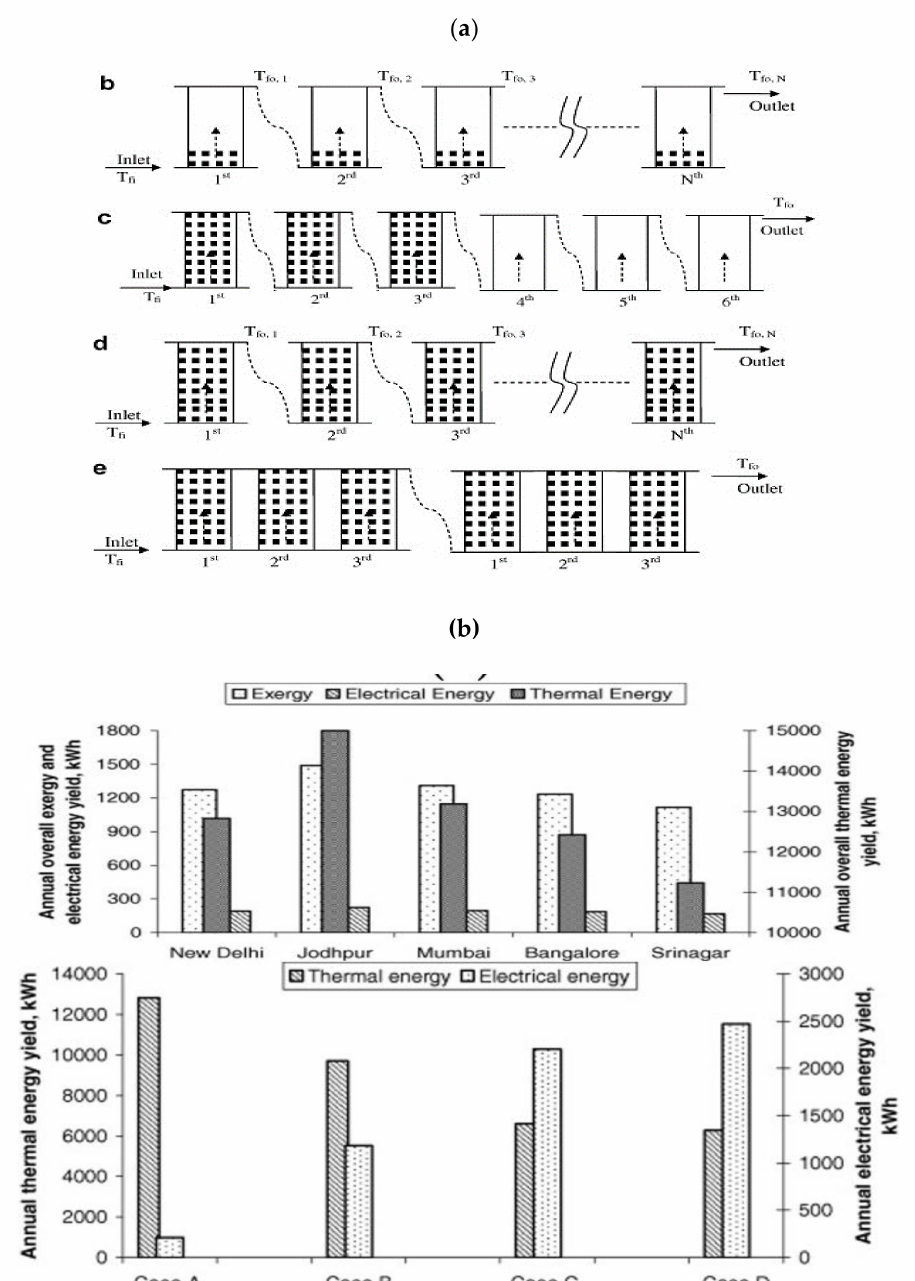
Figure 10. ( a ) Four different configurations (collectors partially covered by PV connected in series, glazed PV-collectors in series, PV-collectors in series, series and parallel combination of PV-collectors); ( b ) annual exergy, thermal and electrical energy values for five cities and four different configurations (reprinted from [77], with permission from